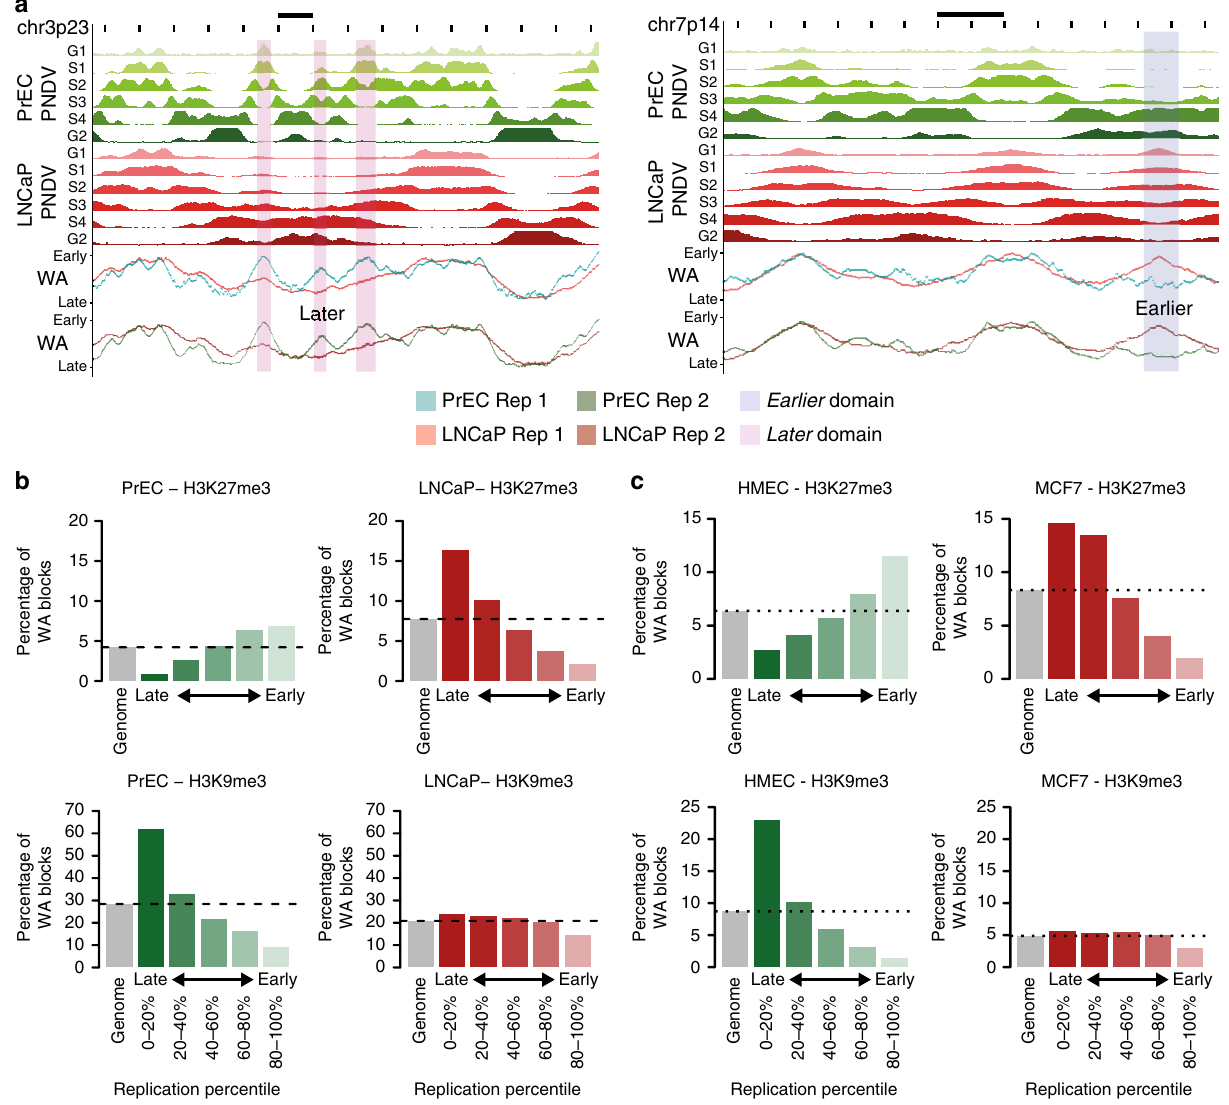
Fig. 1 Relationship between chromatin and replication timing in normal and cancer. a Representative examples of regions of timing change between PrEC and LNCaP. PNDVs for PrEC (green) and LNCaP (red) are shown in the upper panels. The summarised WA values for each replicate are beneath. Regions that replicate later in LNCaP ( Δ WA < − 25) are highlighted in pink. Regions that replicate earlier in LNCaP ( Δ WA > 25) are highlighted in blue. Scale bars represent 1 Mb. b Percentage occupancy of chromatin marks for 1 kb loci (WA blocks) within replication timing percentiles for repressive marks H3K27me3 and H3K9me3 in PrEC and LNCaP. c Percentage occupancy of chromatin marks for 1 kb loci (WA blocks) within replication timing percentiles for repressive marks H3K27me3 and H3K9me3 in HMEC and